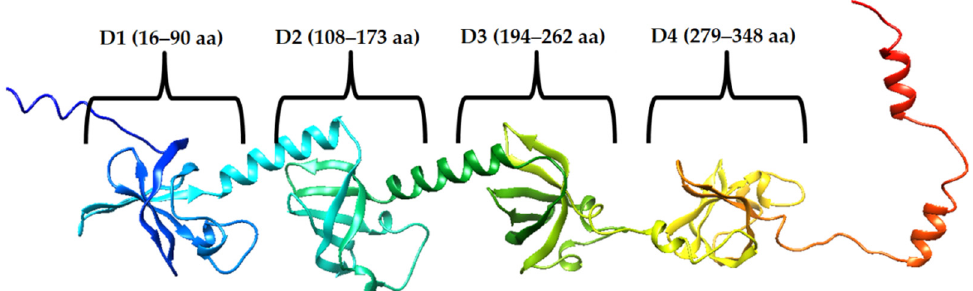
Figure 1. Schematic representation of the domain organization (D1, D2, D3, and D4) of the ribosomal S1 protein from S. aureus . The S1 sequence is taken from the UniProt database (UniProt. Available online: https://www.uniprot.org/uniprot/Q6G987 (accessed on 19 August 2021)). The tertiary structure of S1 was predicted by AlphaFold 2 [41] (AlphaFold 2. Available online: https://github.com/deepmind/alphafold (accessed on 8 September 2021).